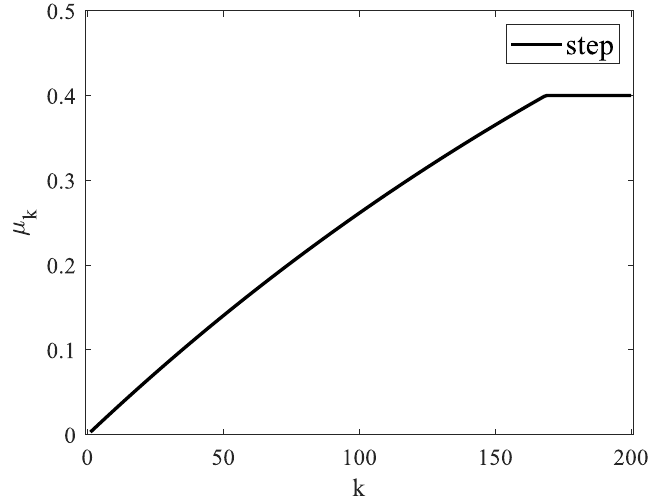
Figure 4. Relationship between the number of iterations and the step size.